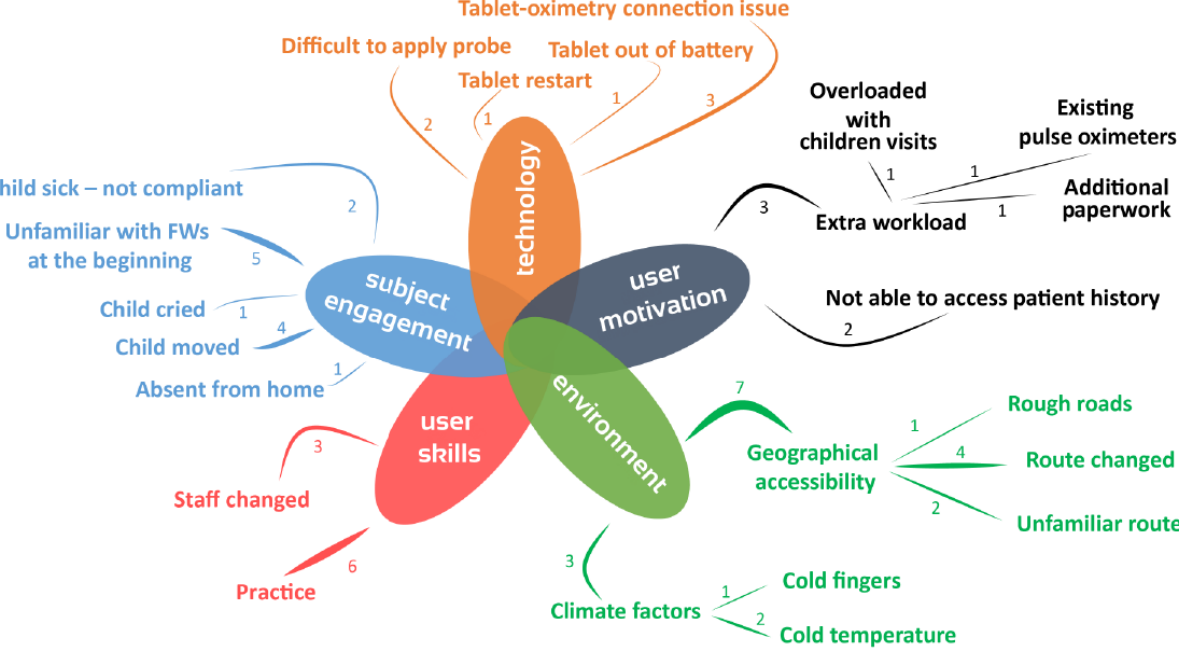
Figure 4. Thematic map showing 5 main challenge categories (technology, environment, user skills, user motivation, and subject engagement) generated by the related codes. The numbers along the connection lines indicate the frequency of occurrence of the codes, therefore, indicating the weight each code contributes to the main challenge. FW: field